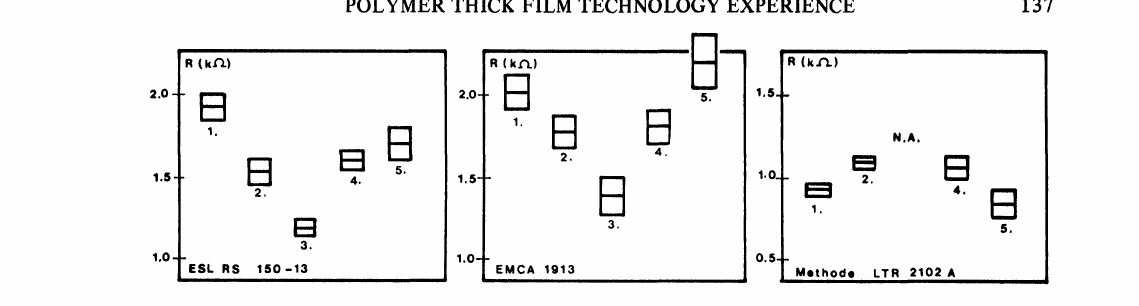
FIGURE 2 Initial resistance values on different substrates (N 512, 1.phenolic paper, 2. bakelite, 3. epoxy class, 4. anadized aluminum, 5. AI 03,96%). the resistor material from Methode formed so thin a film that during the curing process most of the resistors were